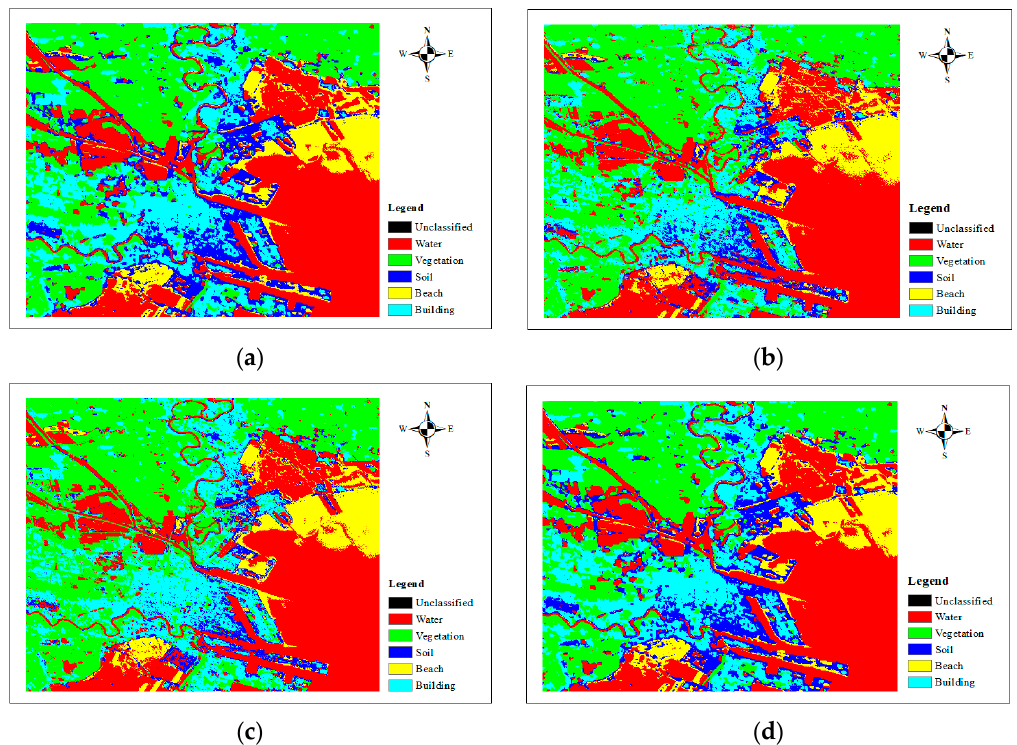
Figure 7. Classification results for the SRR images for Experiment 1 obtained using ( a ) BI, ( b ) POCS, ( c ) IBP, ( d ) MSR-NCHOTV.